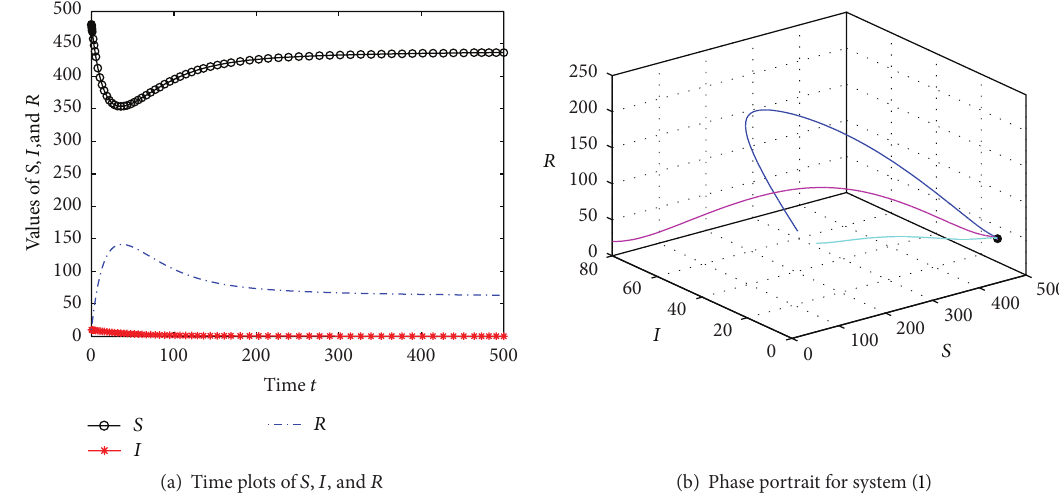
Figure 2: An illustration of the dynamics of system (1) given in Example